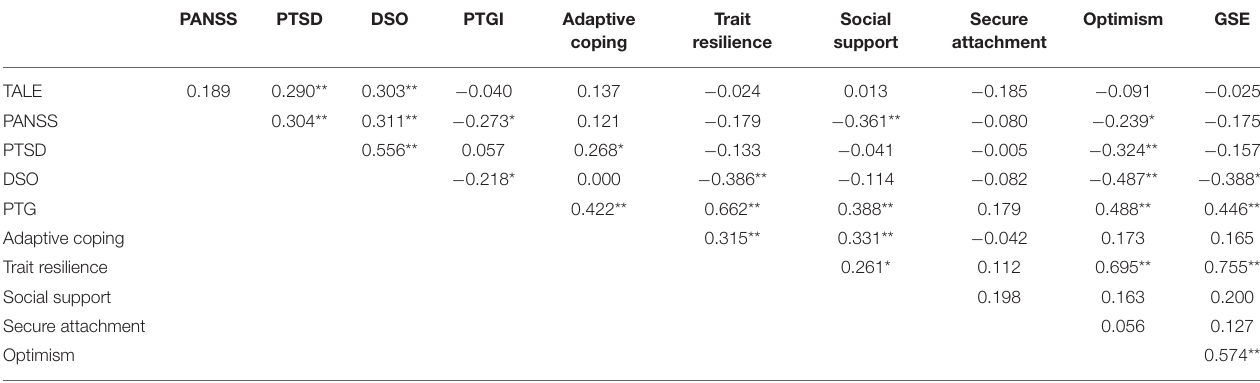
TABLE 2 | Spearman’s ρ